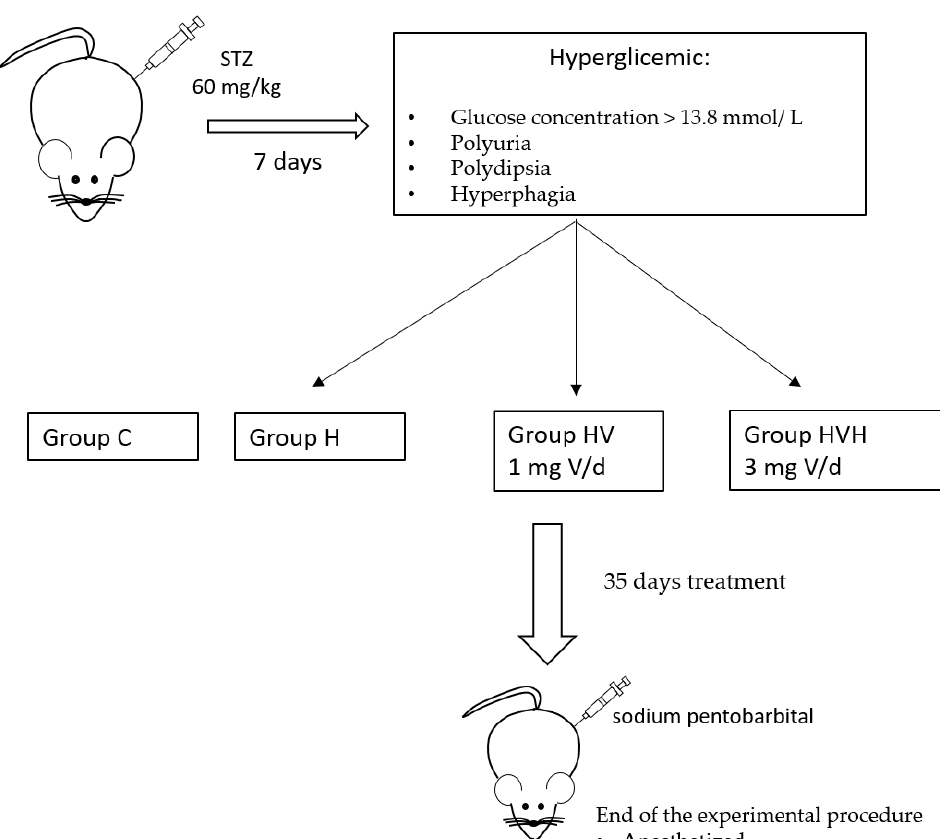
Figure 1. Schematic study design. C (control rats); H (hyperglycemic rats); HV (hyperglycemic rats treated with 1 mg V per day); HVH (hyperglycemic rats treated with 3 mg V per day); STZ (streptozotocin).